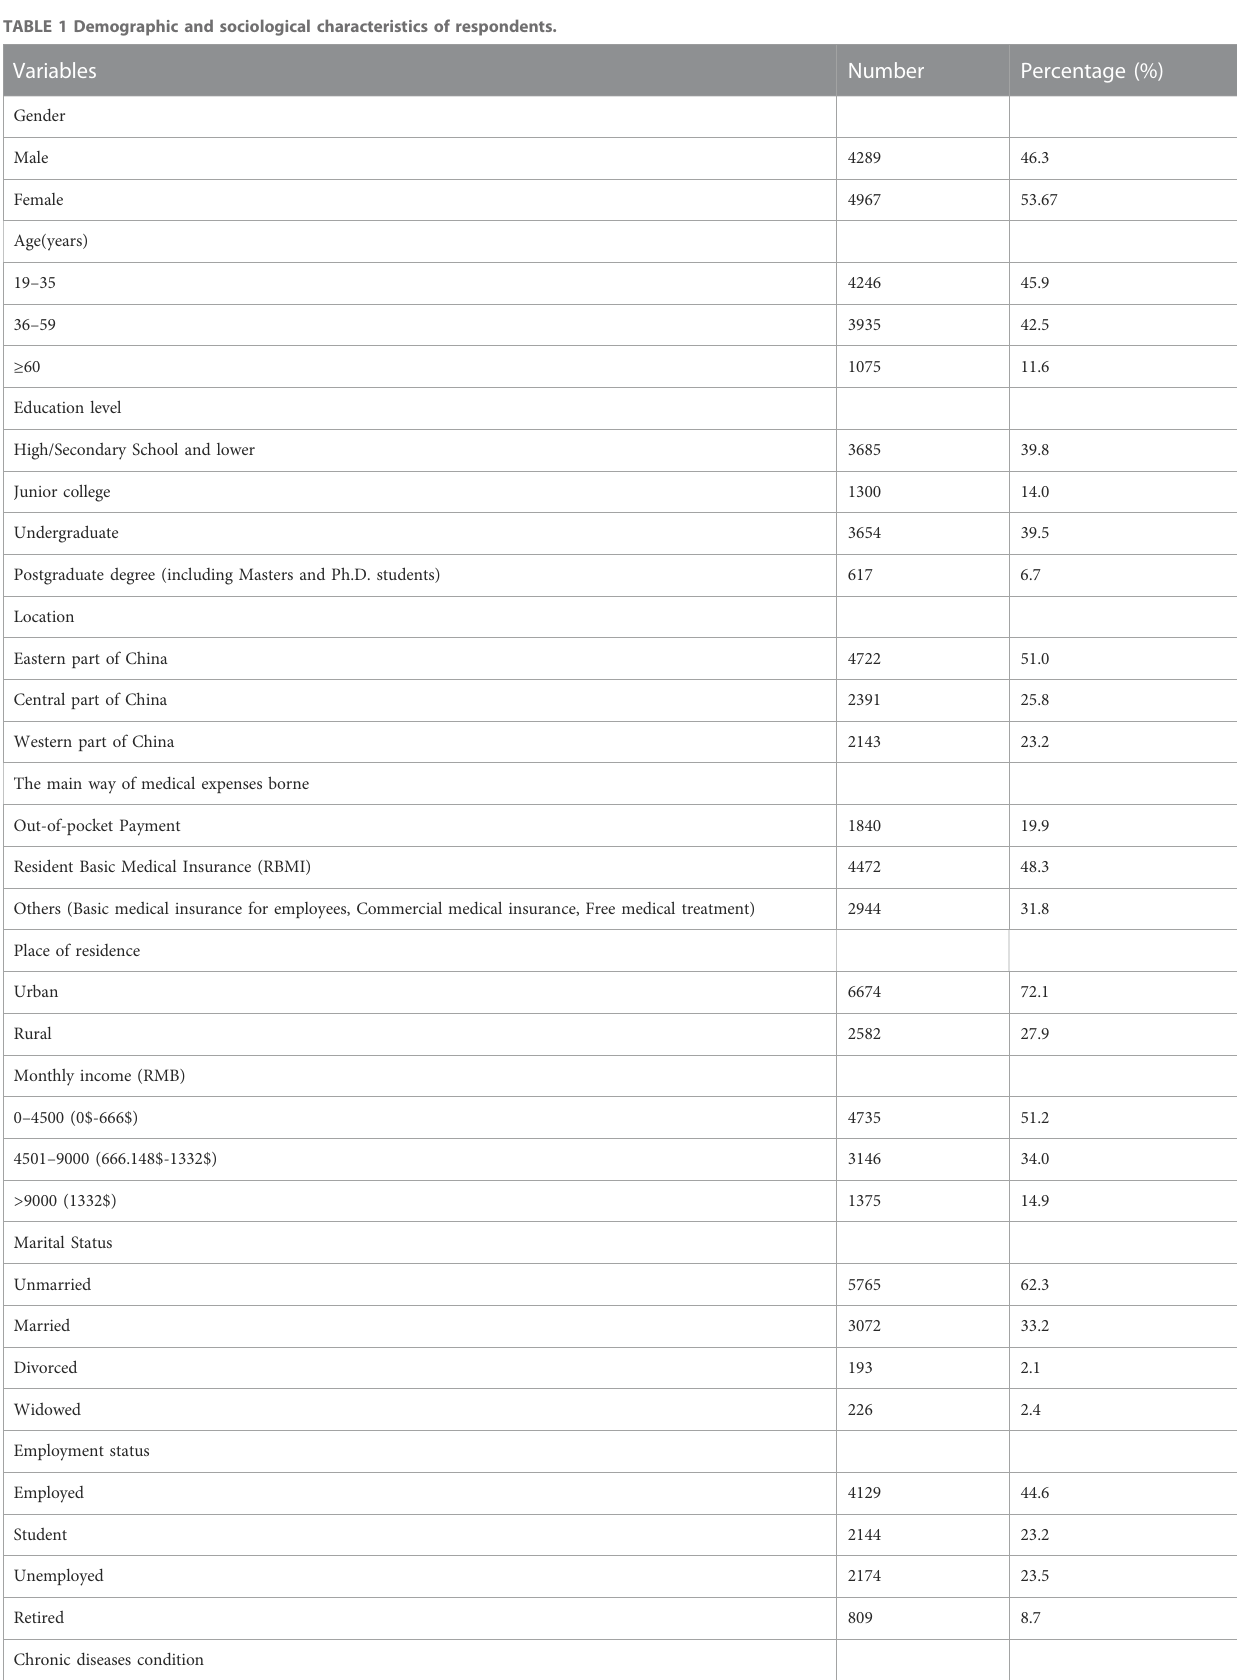
TABLE 1 Demographic and sociological characteristics of